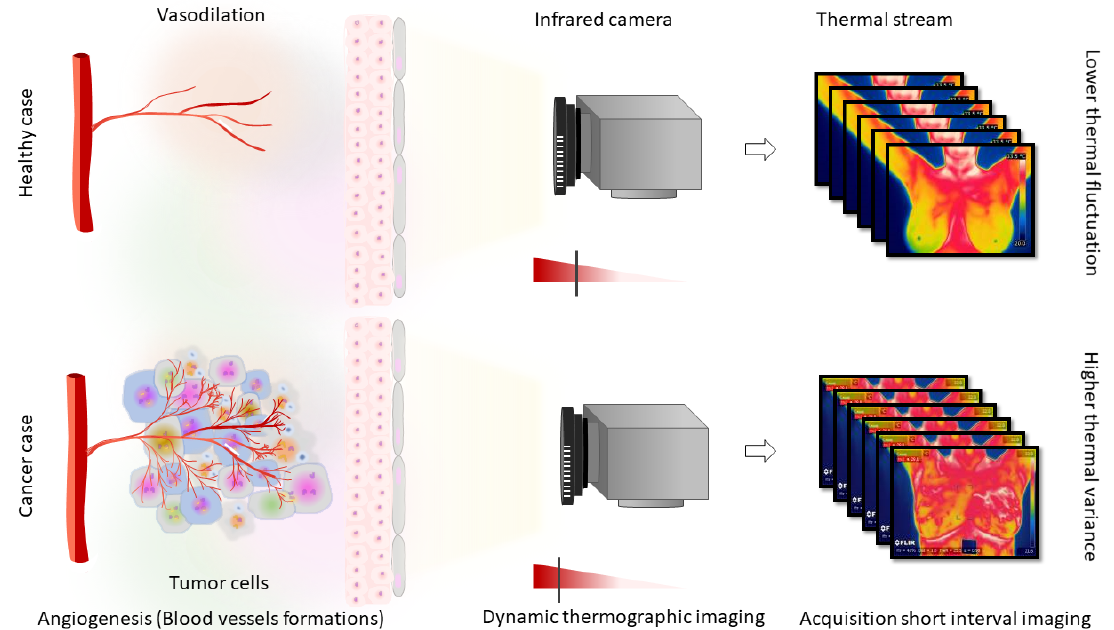
Figure 1. The schematic of angiogenesis (blood vessel formation) surrounding tumor cells in the breast area and vasodilation, which can be captured through short acquisition interval thermal imaging using dynamic thermography.